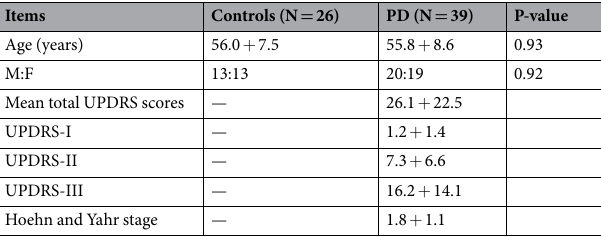
Table 1. Demographical descriptions of controls and patients with Parkinson’s disease (PD).